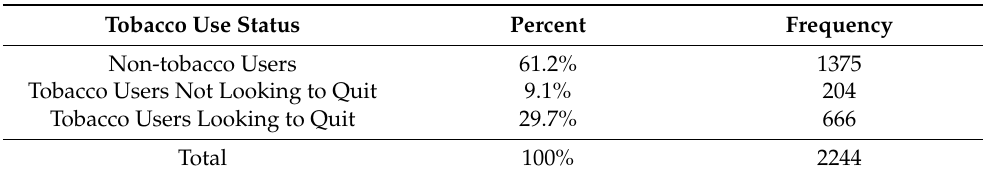
Table 2. Percent and Frequency Distribution of Users by Tobacco Use Status between 14 February 2022–31 March 2022 ( n = 2244).